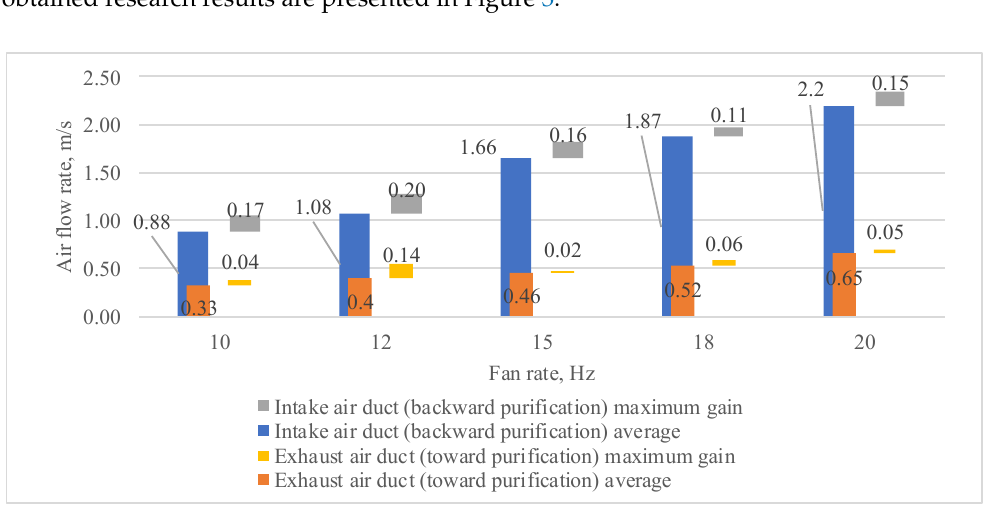
Figure 3. Variation of the air flow rate depending on the fan rate in the intake and exhaust air ducts.